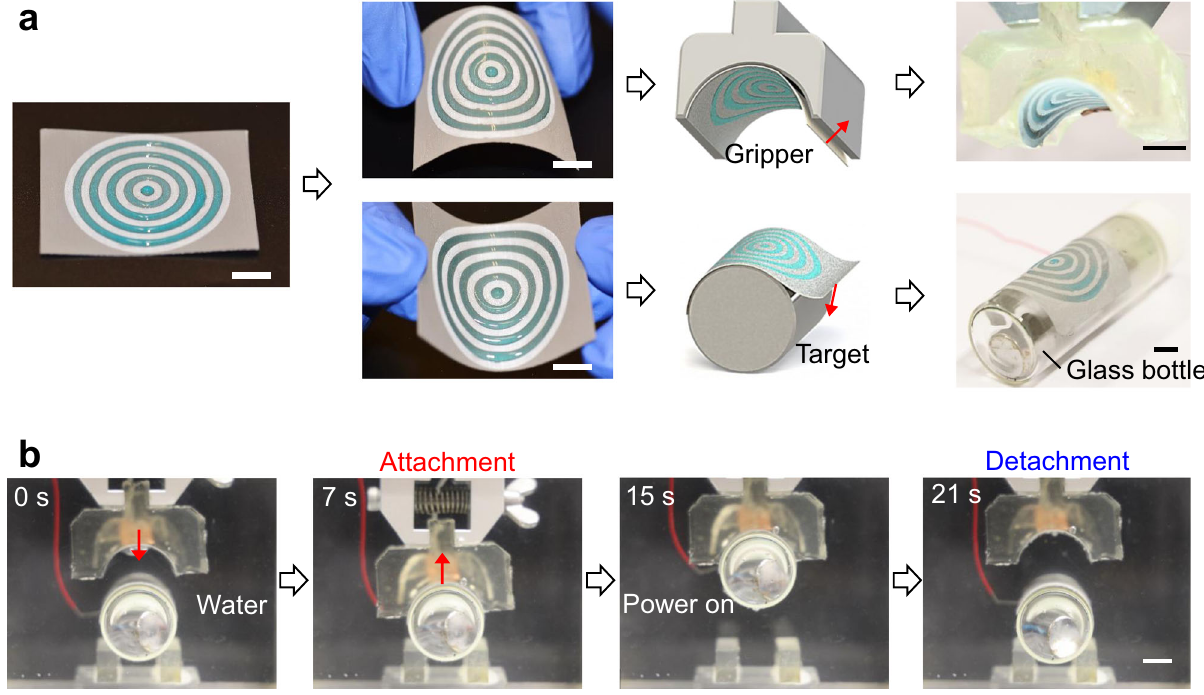
Fig. 5|The fl exibleunderwatercapillaryadhesive.a The constructionof fl exible underwater capillary adhesives on commercial Al tape that is treated with hybrid wettability. Here, the scale bar is 1cm and the width of air ring is set at 2mm.